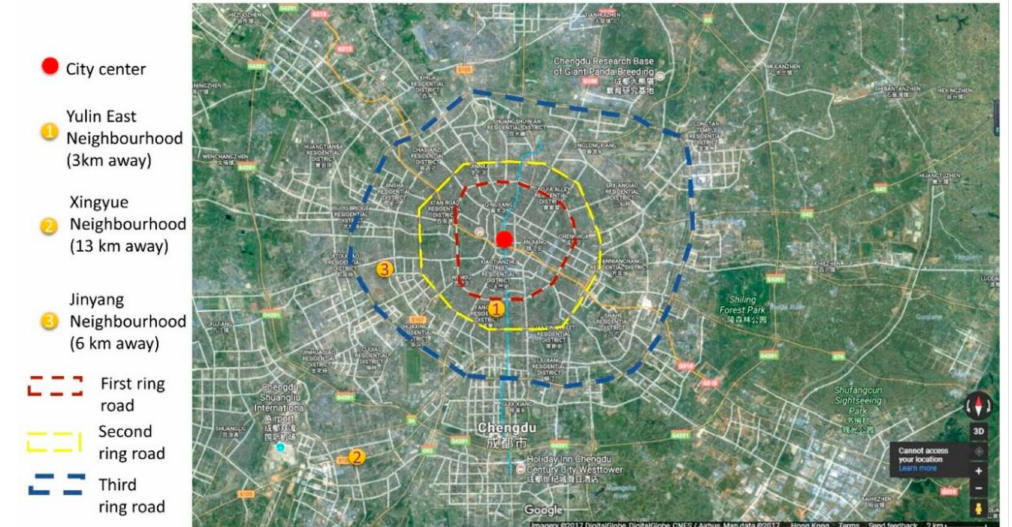
Figure 2. Location of the three neighbourhoods in Chengdu (source: authors’ version based on Google Earth map).